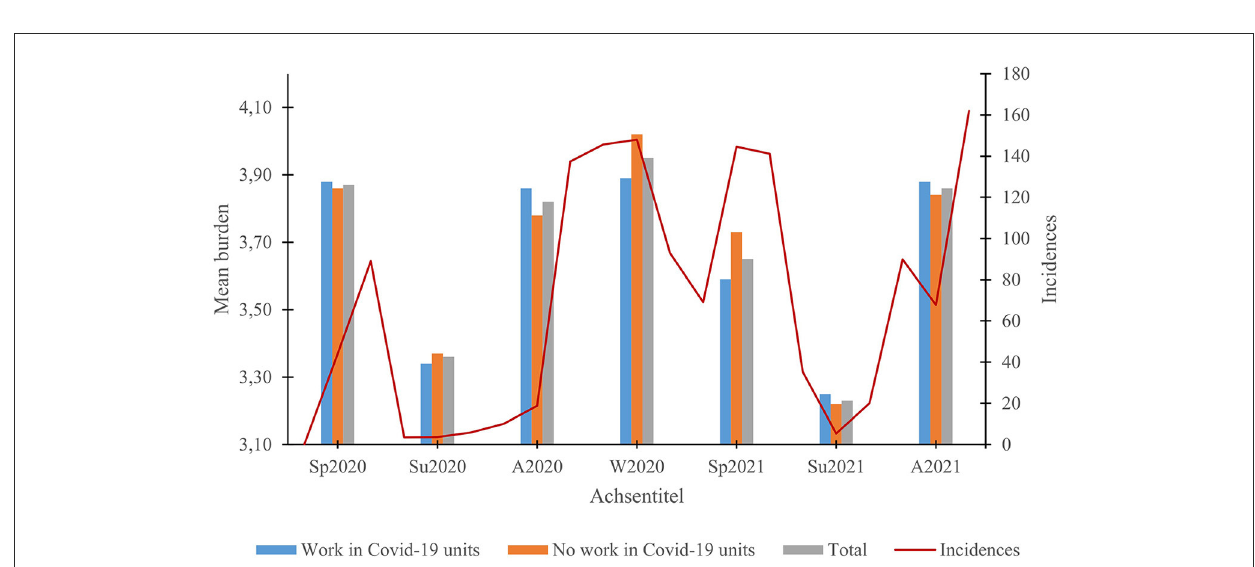
FIGURE2 Subjective burden over time. Presentation of mean burden scores at the different measurement time points for the total sample and the “work in COVID-19 units” and “no work in COVID-19 units” subsamples in relation to the nationwide COVID-19 7-day incidence rate over time at the beginning of each month (for exact scores see Figure